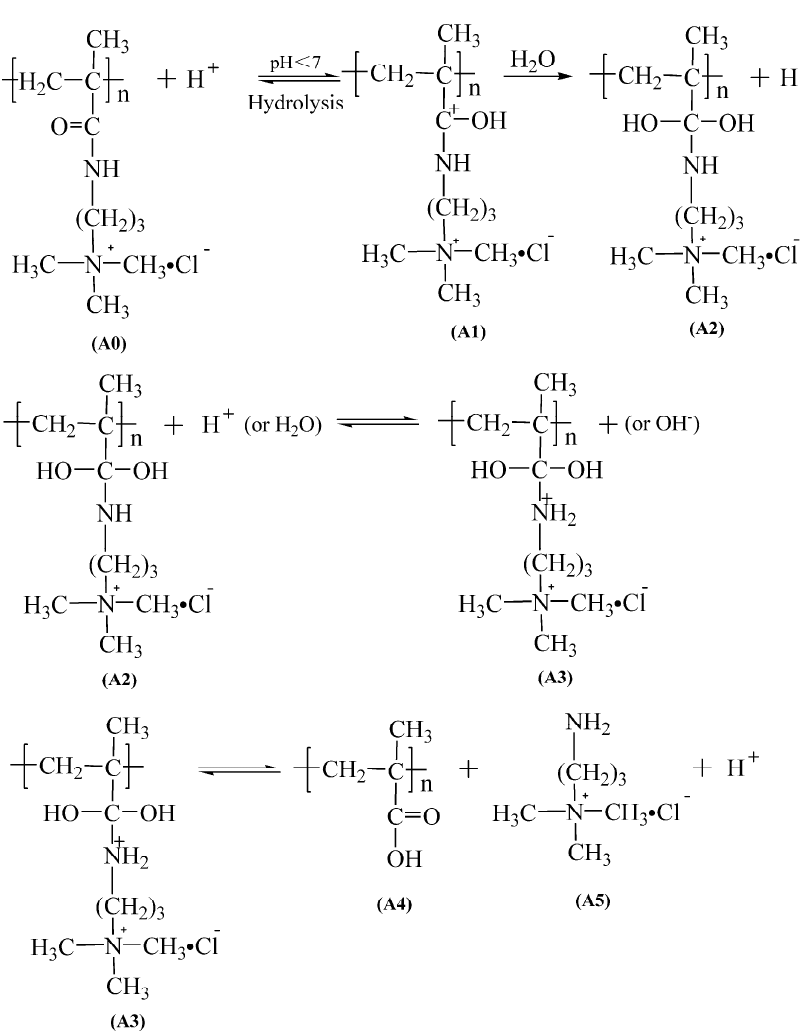
Figure 15. Acid-catalyzed amide hydrolysis mechanism of PMAPTAC.